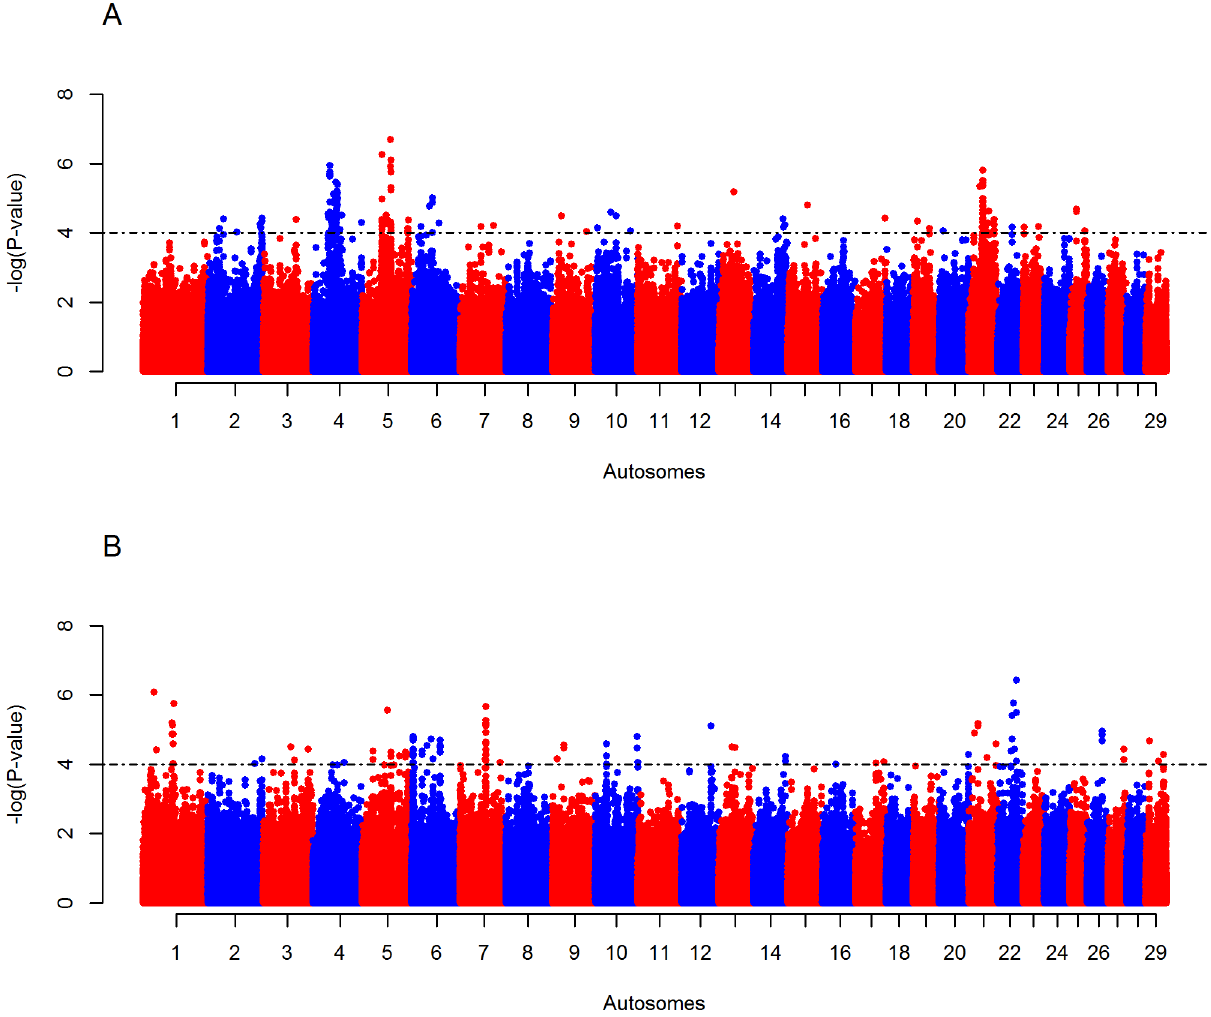
Fig 3. Manhattan plots of genome-wide iHS analyseson (A) Butana and (B) Kenana cattle. two-tailedZ-test is appliedand the significancethreshold is set at–log 10 (two-tailed P -value)= 4.